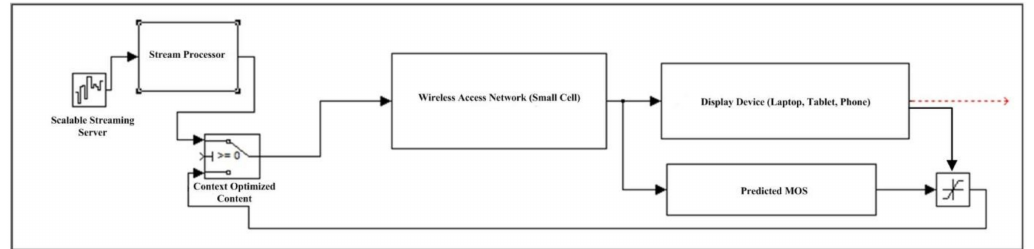
Figure 21. Adaptive video streaming simulation